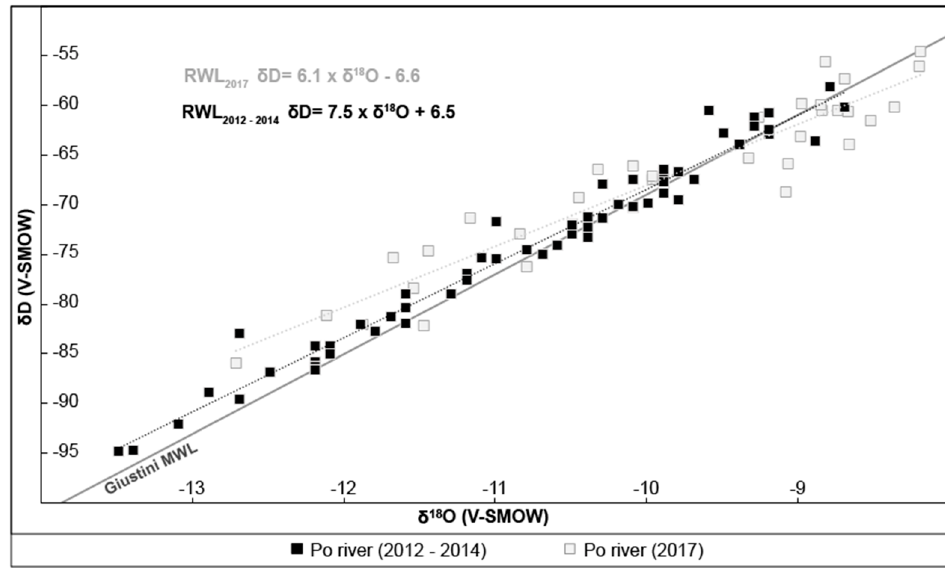
Figure 3. The δ D vs. δ 18 O of Po river water (data from Tables 1 and 2 and Supplementary Tables S1 and S2 in the Supplementary Materials) along the main course and the Pontelagoscuro section. The new data (hydrological year 2017) and the relative regression lines are compared with those recorded in Po river water during the years 2012–2014. Regression lines have been calculated using the Ordinary Least Square (OLS) regression method, traditionally used to calculated the meteoric water line [41]. The Local Meteoric Water Line (LMWL) defined for Northern Italy [36] is also reported in grey for comparison.